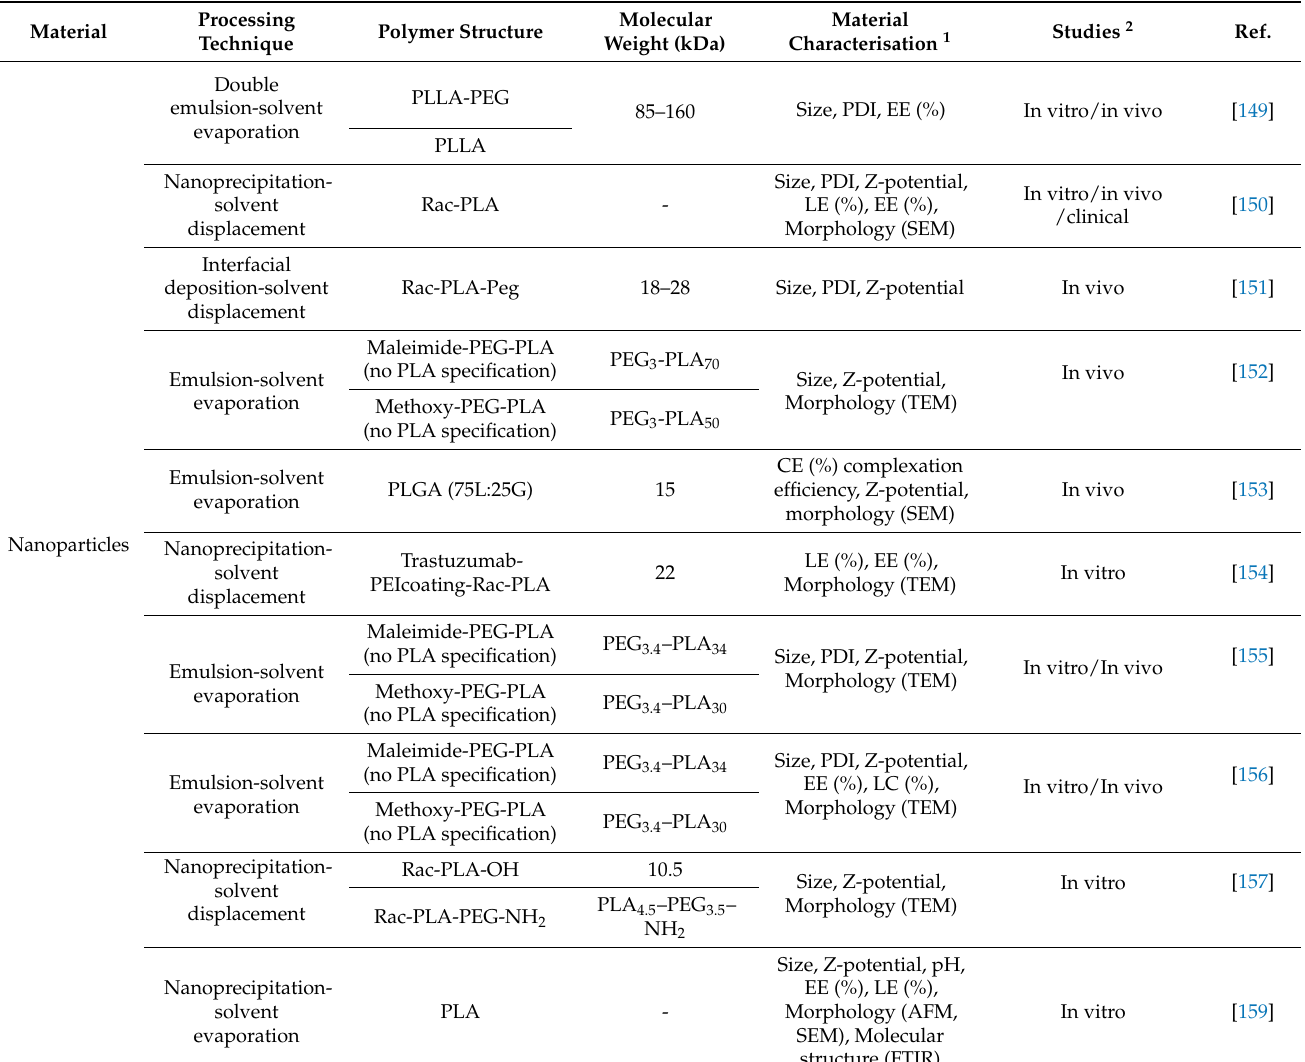
Table 1. Summary of the PLA-derivative